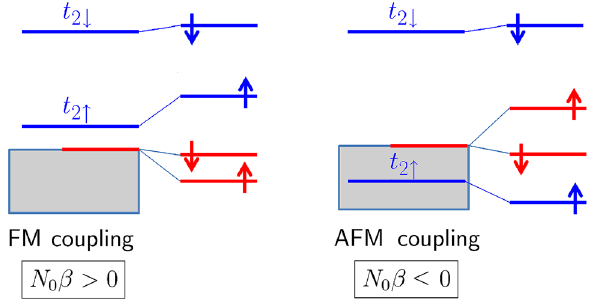
Figure 5. Dependence of the p – d exchange coupling on the energies of the t 2 σ (TM) levels. The hybridization occurs between the states with the same spin, and is spin-dependent. Left panel: both t 2 ↑ and t 2 ↓ are above the VBM. t 2 ↑ is closer to the VBM than t 2 ↓ , and thus its interaction with the VBM is stronger. The resulting spin splitting corresponds to the FM p – d exchange coupling. Right panel: t 2 ↑ is below the VBM, and the t 2 ↓ is above the VBM, which results in the AFM coupling. Gray area is the valence band. Arrows indicate spin direction of levels only, and occupations are not shown. Left panel represents e.g. Mn in ZnO, and the right one Mn in CdTe. Crystal field splittings of the triplets are neglected for